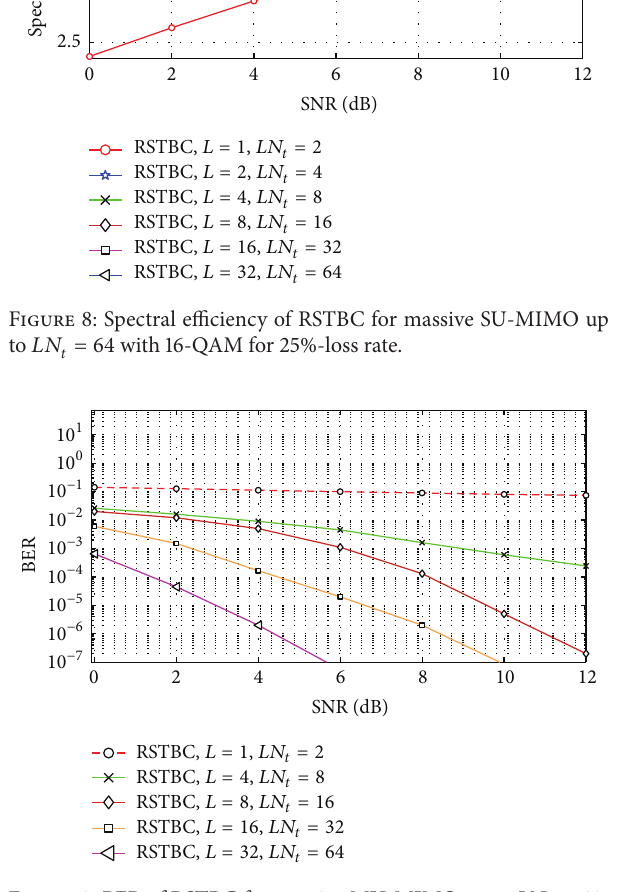
Figure 9: BER of RSTBC for massive MU-MIMO up to 𝐿𝑁 𝑡 = 64 ( 𝐾 = 2 users) with 16-QAM for 25%-loss